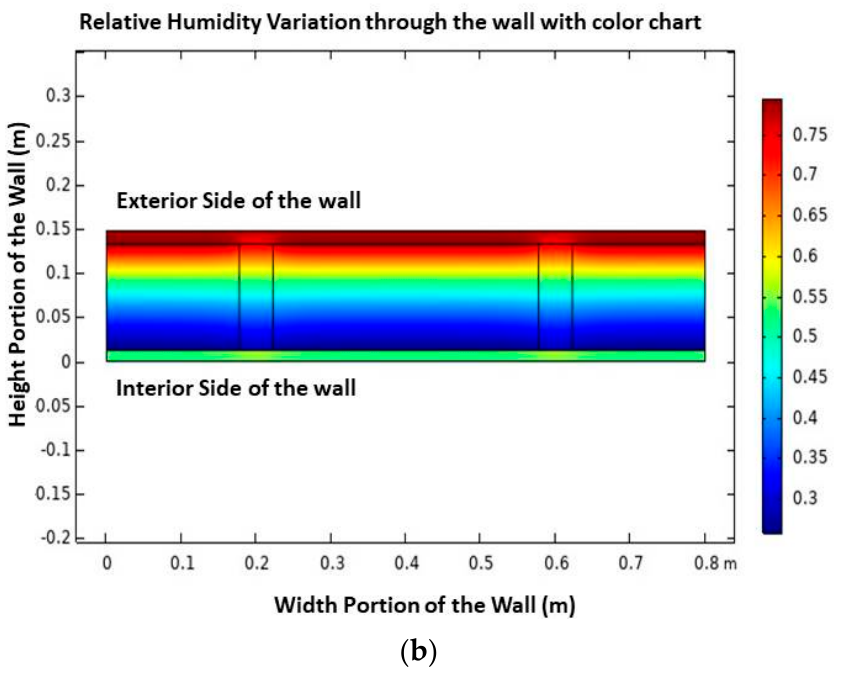
Figure 4. Two-dimensional cross-sectional view: ( a ) surface temperature variation and ( b ) relative humidity through the wall structure.